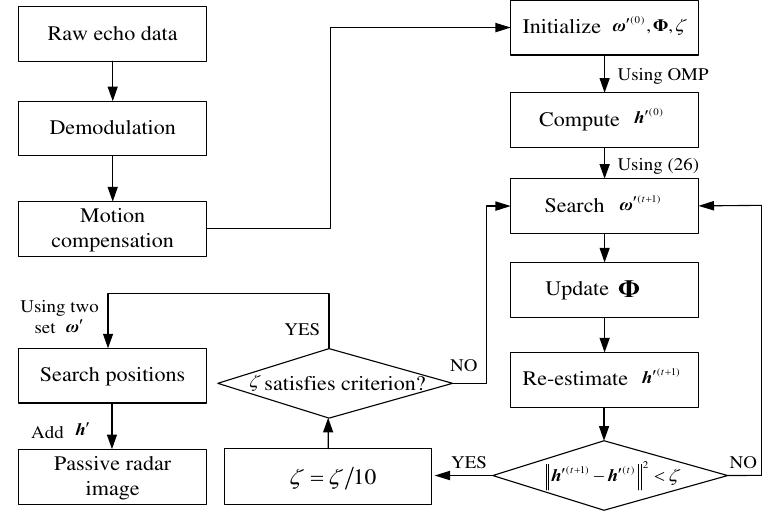
Figure 2. Flowchart of the proposed compressed sensing (CS)-based method for passive radar